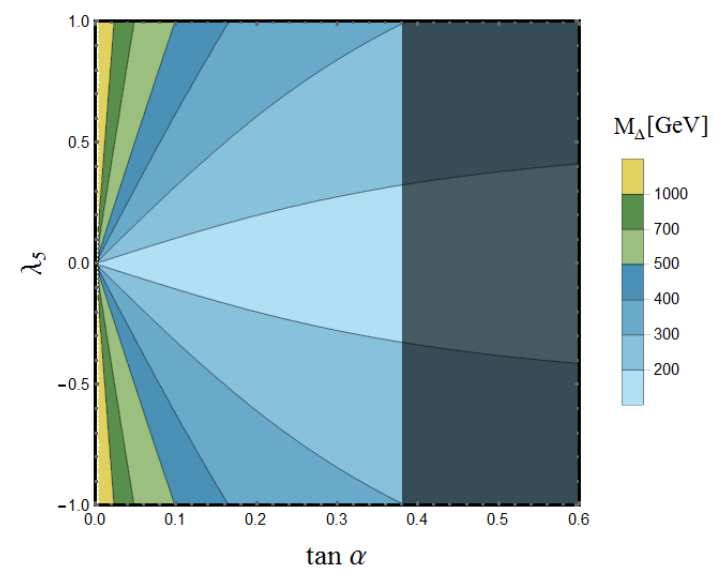
Figure 1 . Contour plot for M (cid:1) in (cid:21) 5 (cid:0) tan (cid:11) plane. Mass scale for di(cid:11)erent color shaded regions is shown in the right side of the (cid:12)gure. Black shaded zone is excluded by current experimental